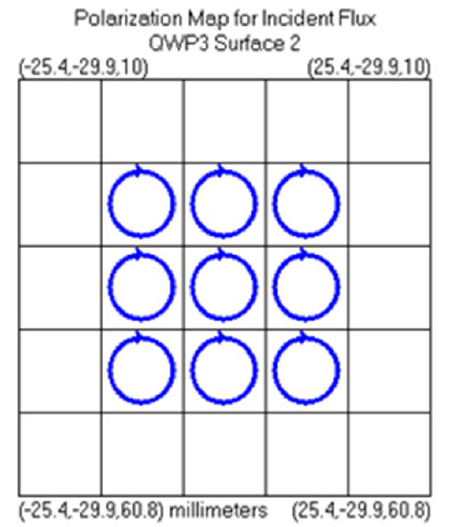
Figure 4. The polarization state of the light wave emitted from arm 1 after passing through QWP 3